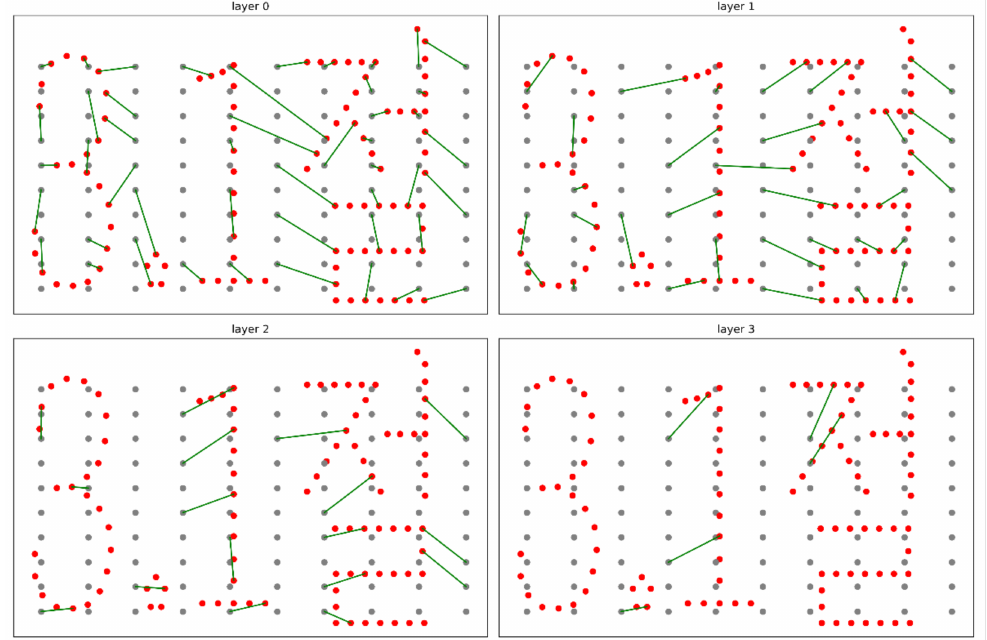
Figure 22. Layers for the second scene. (S1 →